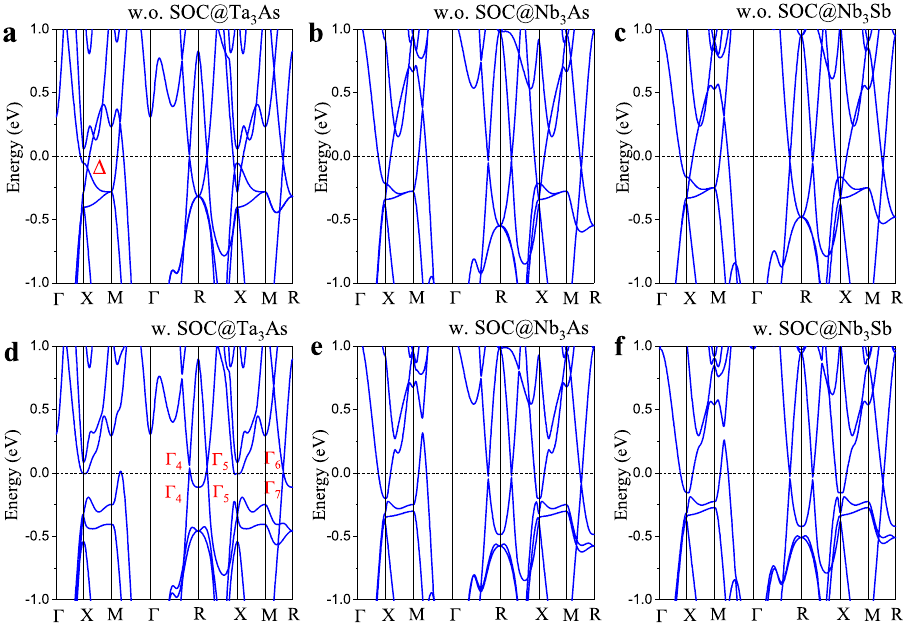
Fig. 2 Calculated band structure of X 3 Y family materials without and with spin-orbit coupling (SOC). a , d Band structure of Ta 3 As without and with SOC (the left column); b , e That of Nb 3 As (the middle column); c and f That of Nb 3 Sb (the right column). Here, the position of point Δ (panel a ) related to band inversion contributes to the large SHC.